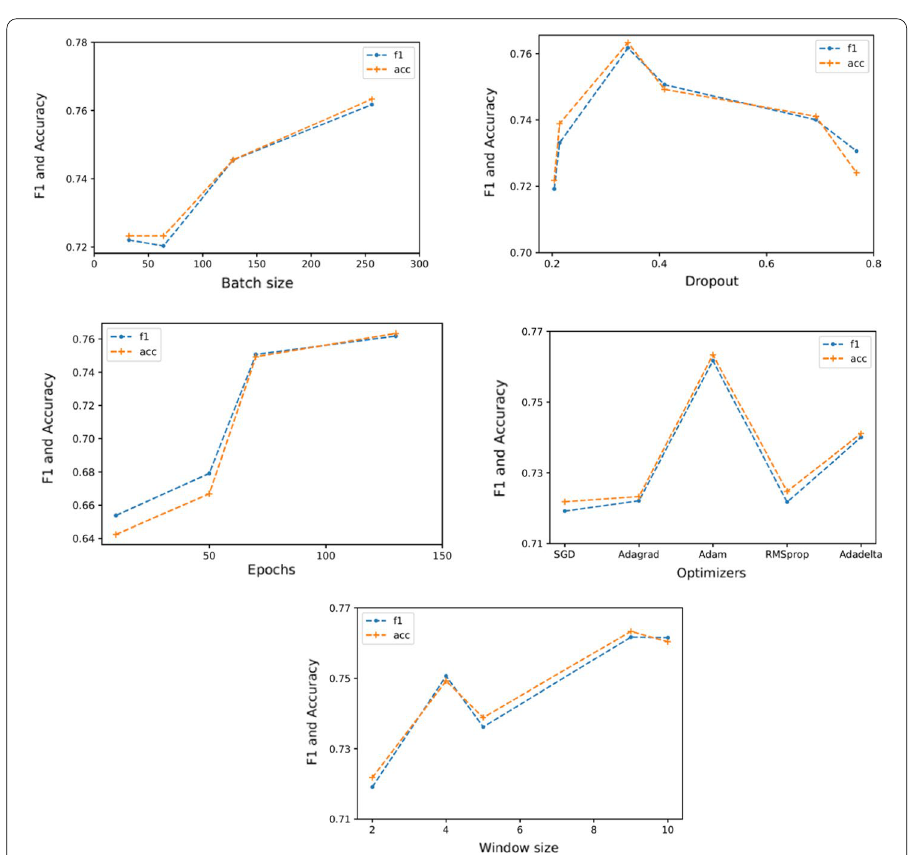
Fig. 7 Relationship between hyper-parameters and performance metrics (F1-score (f1) and Accuracy